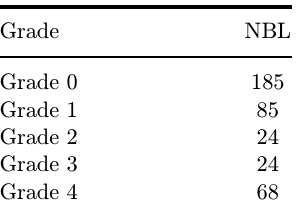
Table 3. The NBL detected in grades